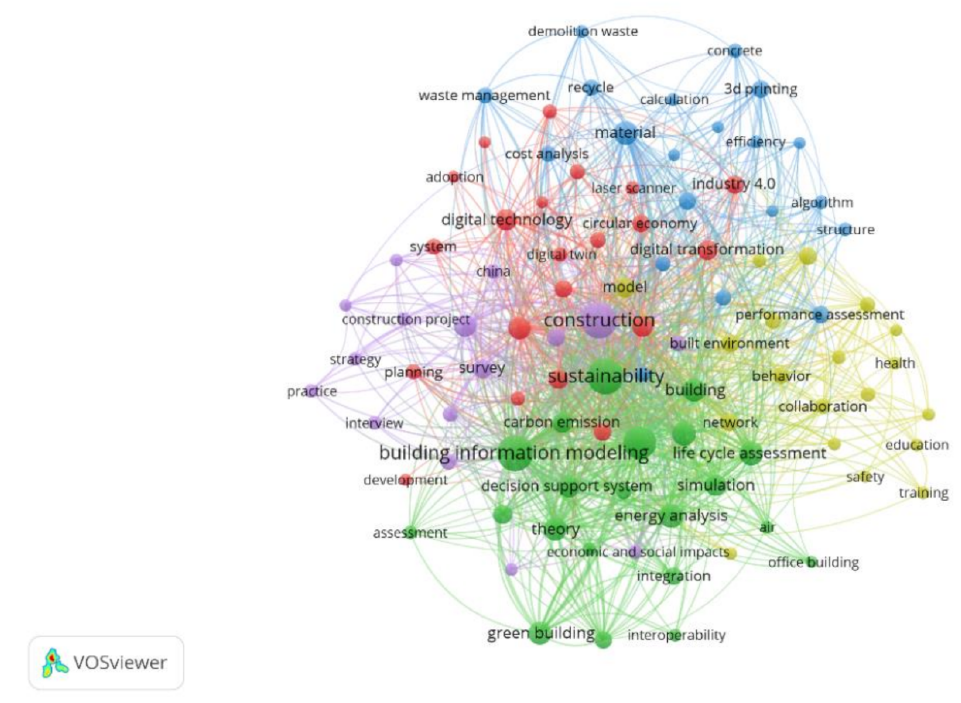
Figure 7. Density visualization of author